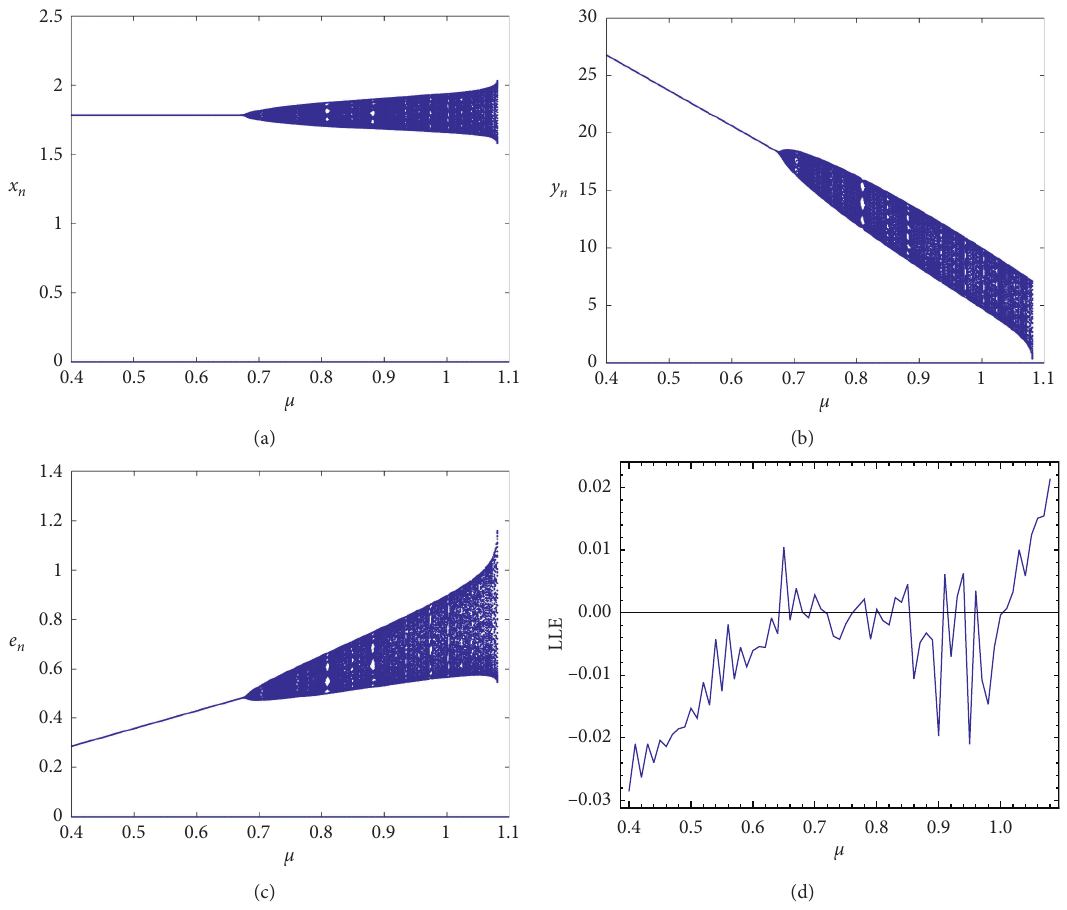
Figure 5: Bifurcation diagrams and LLE for system (3) with a � 41 . 5, b � 85, c � 2 . 7, d � 3 . 4, k � 1 . 4, r � 3 . 5, p � 2 . 3, h � 0 . 75, , y , e ) � ( 1 . 5 , 5 . 58 , 0 . 775 ) . (a) Bifurcation diagram for x μ ∈ [ 0 . 4 , 1 . 1 ] , and ( x 0 0 0 e n . (d) Largest Lyapunov